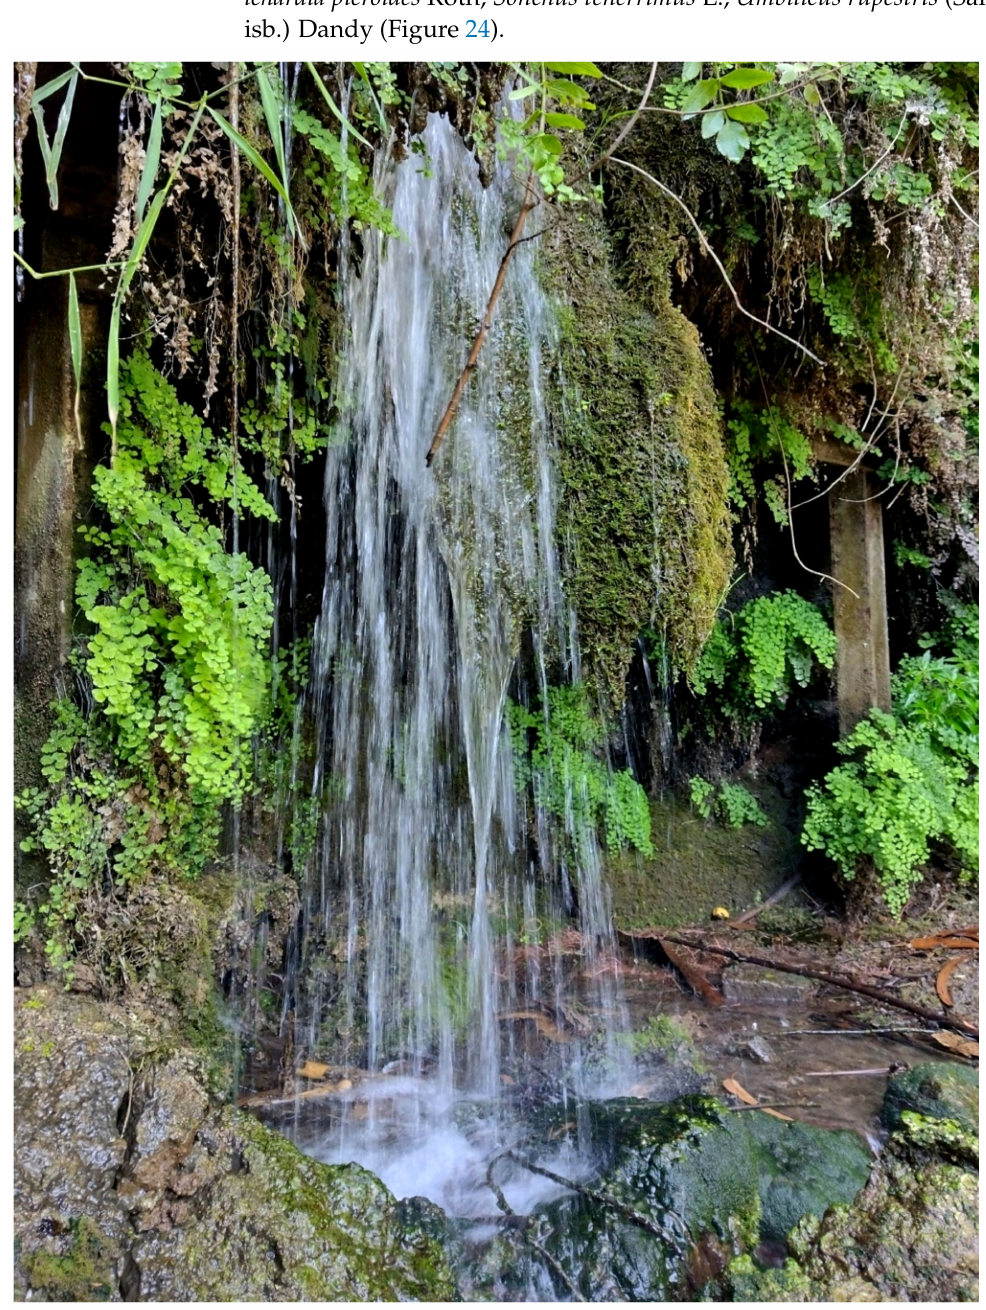
Figure 23. Adiantetea on the volcanic cliffs of channel Acqua Mariana (Acquedotti